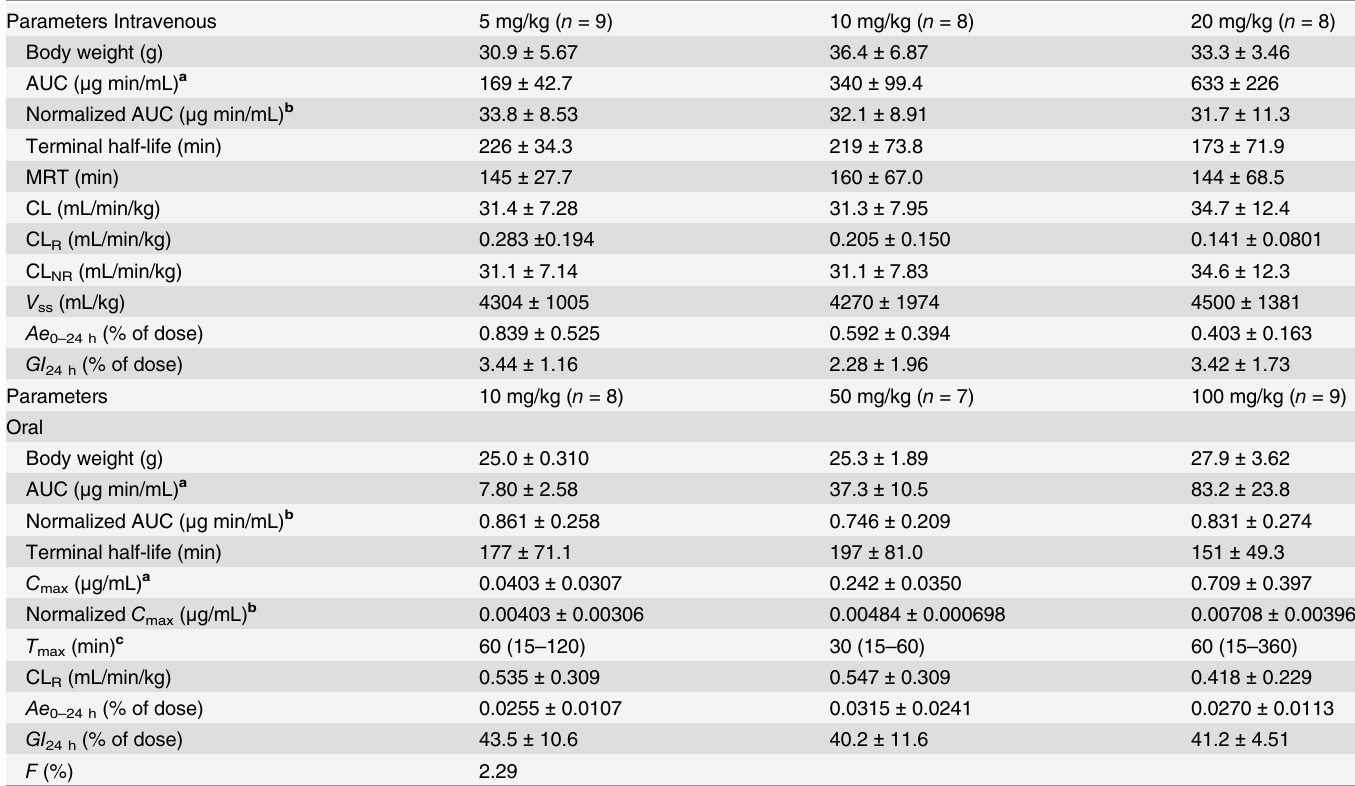
All values were statistically analyzed and all of them were not statistically different (p < 0.05) except AUC and C max values among three doses. a Statistically different (p < 0.05) among three doses. b Normalized values based on 1 mg/kg were not statistically different among three doses. c Median (ranges) for T max